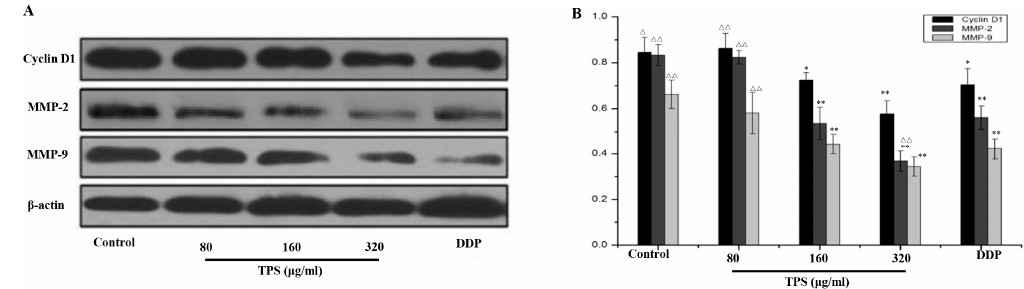
Figure 6. ( A ) Expression of the proteins cyclin D1, MMP-2, and MMP-9 in CT26 cells by Western blots. ( B ) Densitometric analysis was performed to determine the relative levels of cyclin D1, MMP-2, and MMP-9. Bar graphs show mean ± SD of three independent experiments. * p < 0.05, ** p < 0.01 vs. control group. △ p < 0.05, △△ p < 0.01 vs. DDP group.